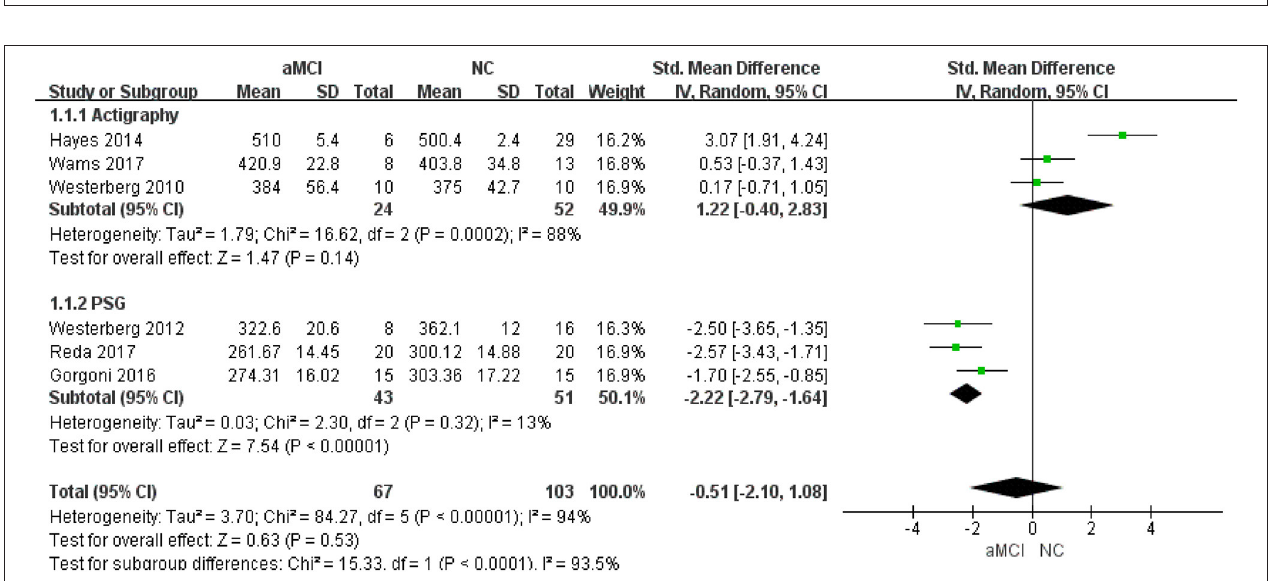
FIGURE 2 | Meta-analysis of TST between the aMCI and NC groups.